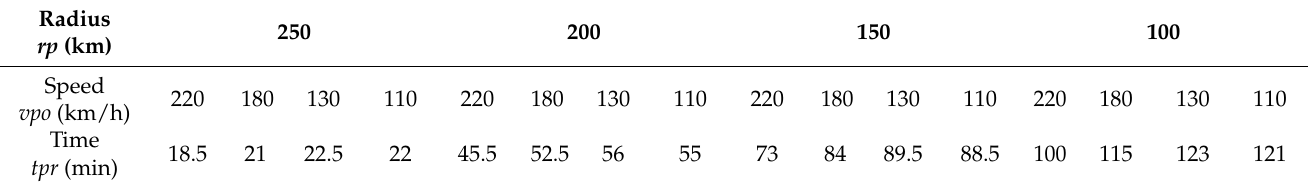
Table 6. Dependence of the maximum working time in the search area, depending on the search speed at a constant cruising speed vp = 220 km/h and the search radius rp